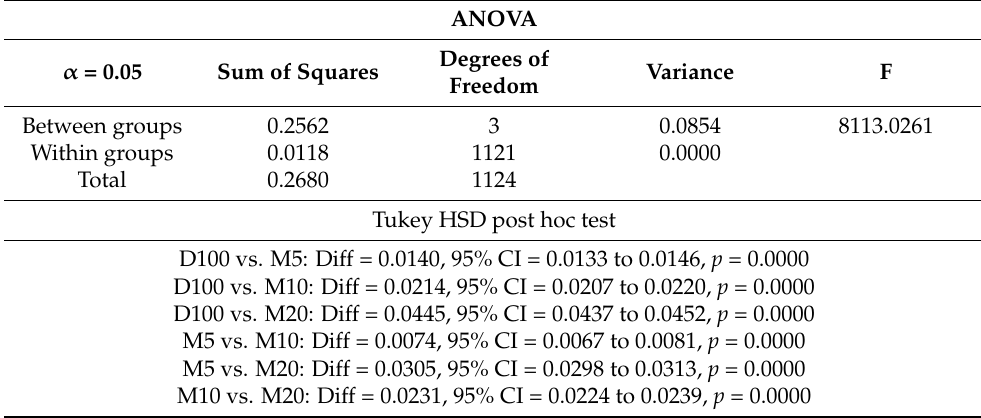
Table 12. Results of ANOVA with Tukey HSD post hoc test for C 4 H 6 at the measurement point 2. ANOVA